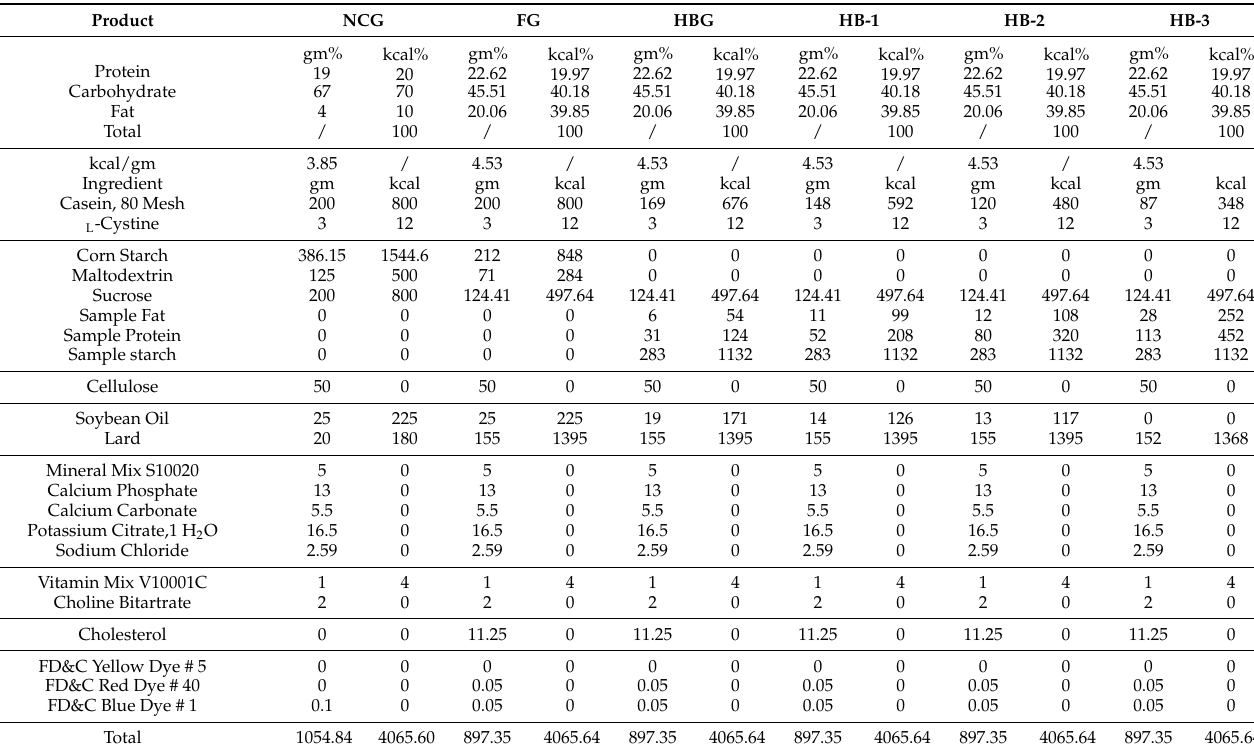
Table 2. Basic diet composition and nutrition levels for the studied